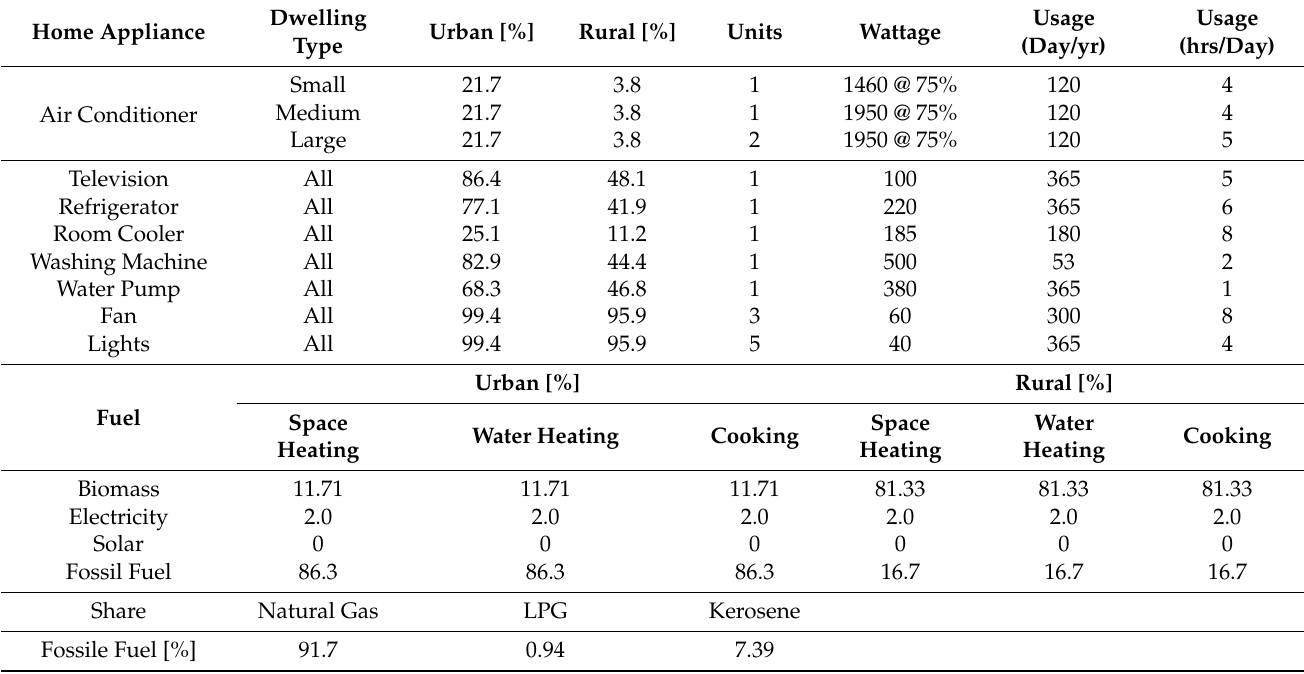
Table 8. Ownership and energy requirement details of electric appliances and the share of different fuels and household sectors